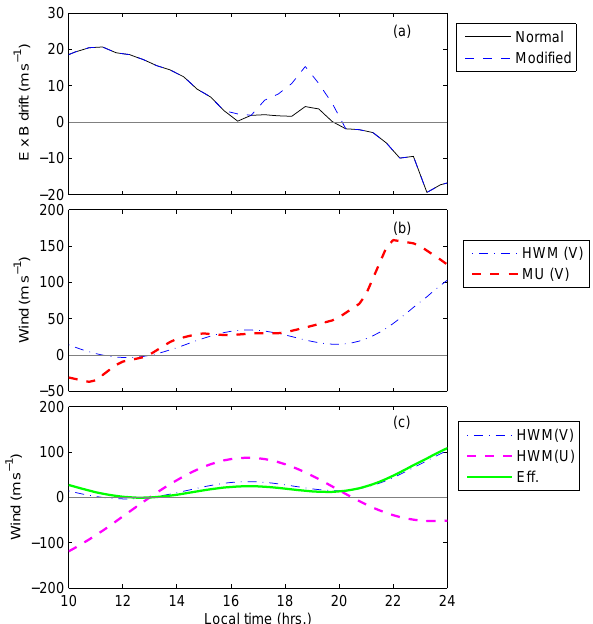
Fig. 7. Local time variation of N max values obtained from differ- ent simulations. These outputs also correspond to 38 ◦ N magnetic